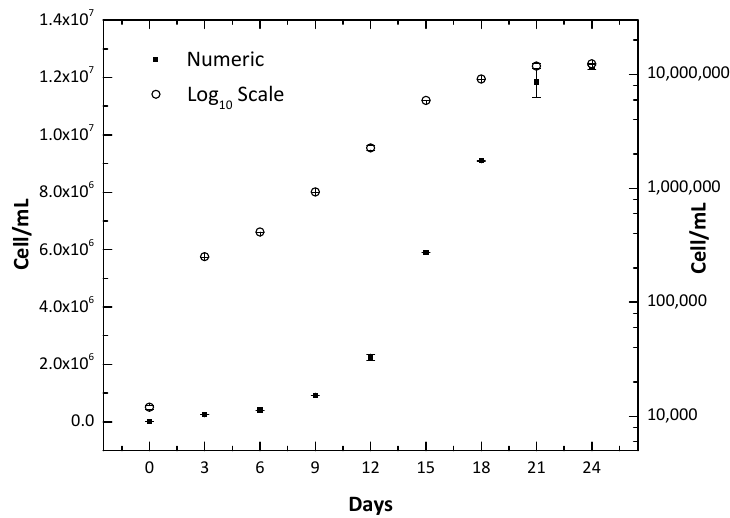
Figure 1. Microcystis aeruginosa LTPNA 01 growth curve in both numeric and log10 scales. Error bars denote standard deviation (SD).